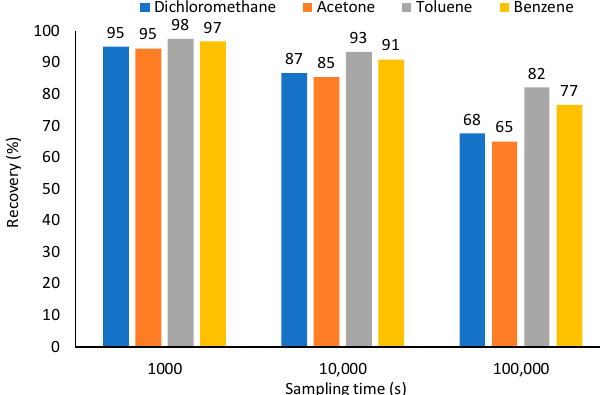
Figure 4. Effect of sampling time of TWA recoveries of analytes having different diffusion coefficients and distribution constants using 85- μ m Car/PDMS fiber ( T = 298 K, Z = 10 mm, 24 ga needle, p = 1 atm, C = 0.641 μ mol·m − 3 ).